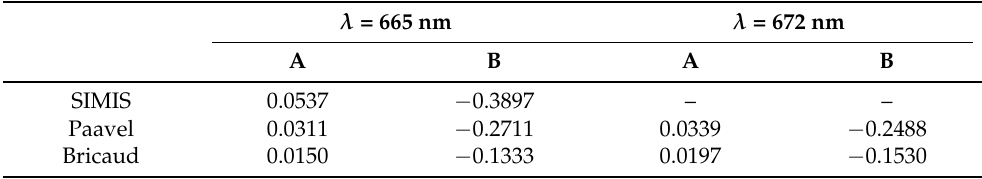
Table 1. Constant A and B values estimated in the present study with the SIMIS algorithm and found in the literature [41,44] for λ equal 665 and 672